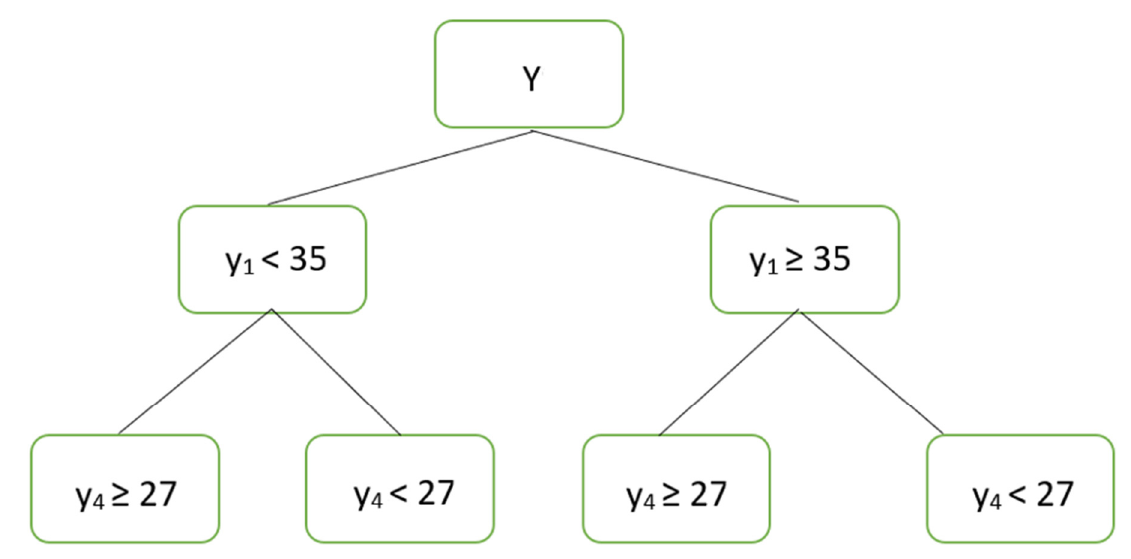
Figure 3. A simple tree at classification.